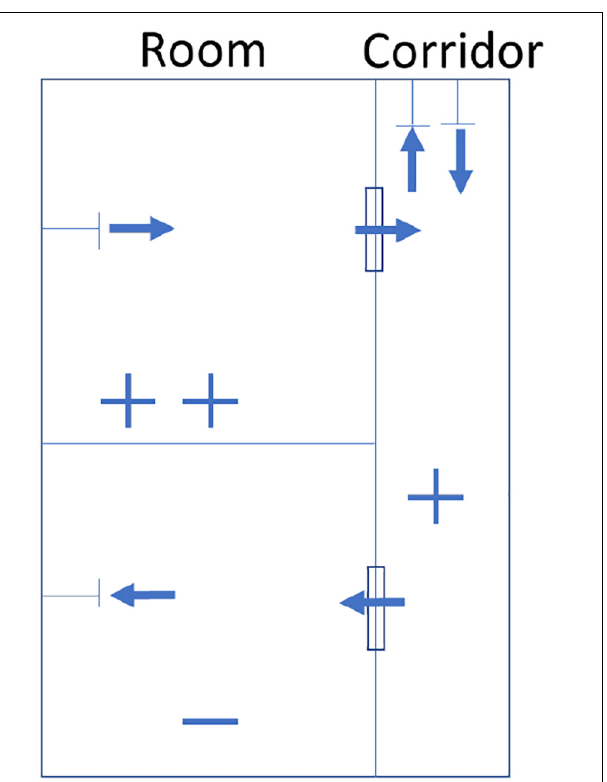
FIGURE 2 | Directed airflow with relative internal pressure for two rooms and a corridor; (+) is positive pressure (higher pressure), (–) is negative pressure (lower pressure), and ( → ) denotes airflow.